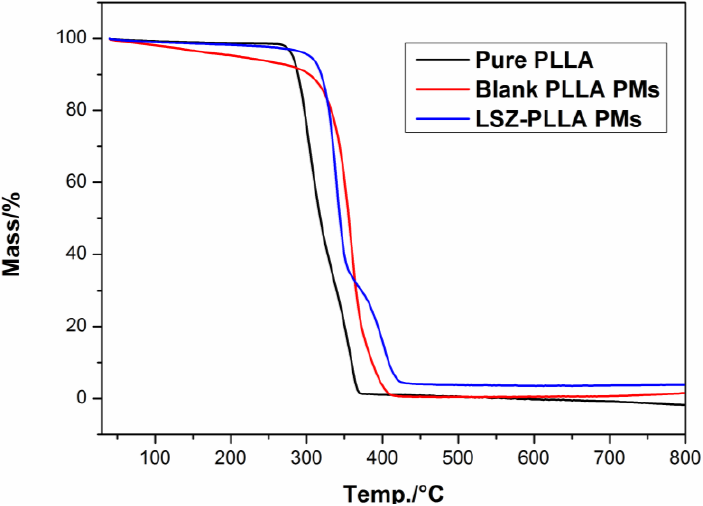
Figure 7. Thermogravimetric analysis (TGA) curves of pure PLLA, blank PLLA PMs and LSZ-PLLA